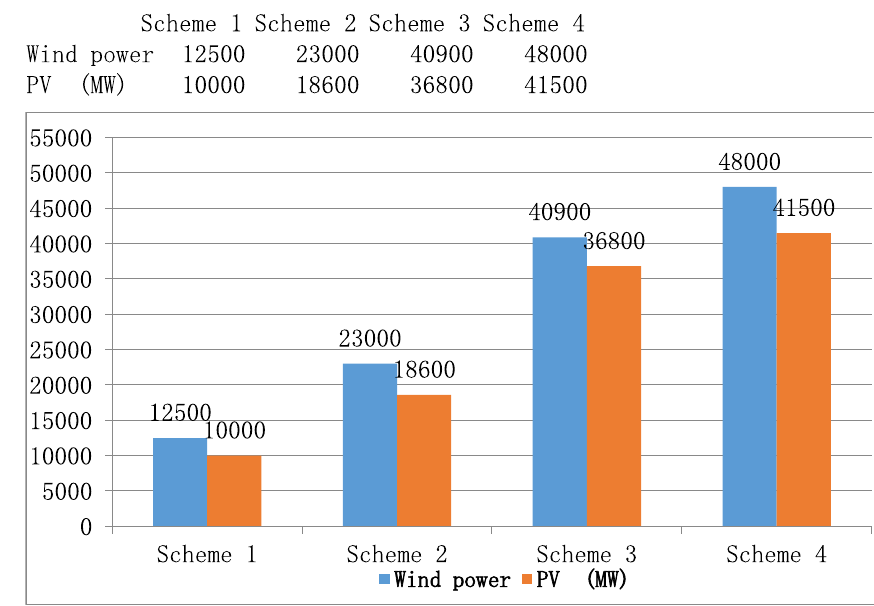
Fig. 6 Wind power and PV power accommodation capacity of Northwest